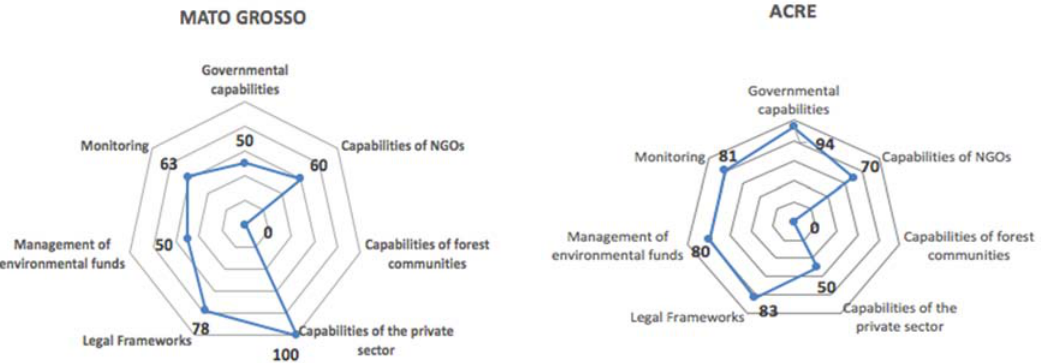
Figure 2. Performance of Mato Grosso and Acre’s capacities, based on the scores attributed to the thematic blocks and the social players evaluated (data from the OAF application).